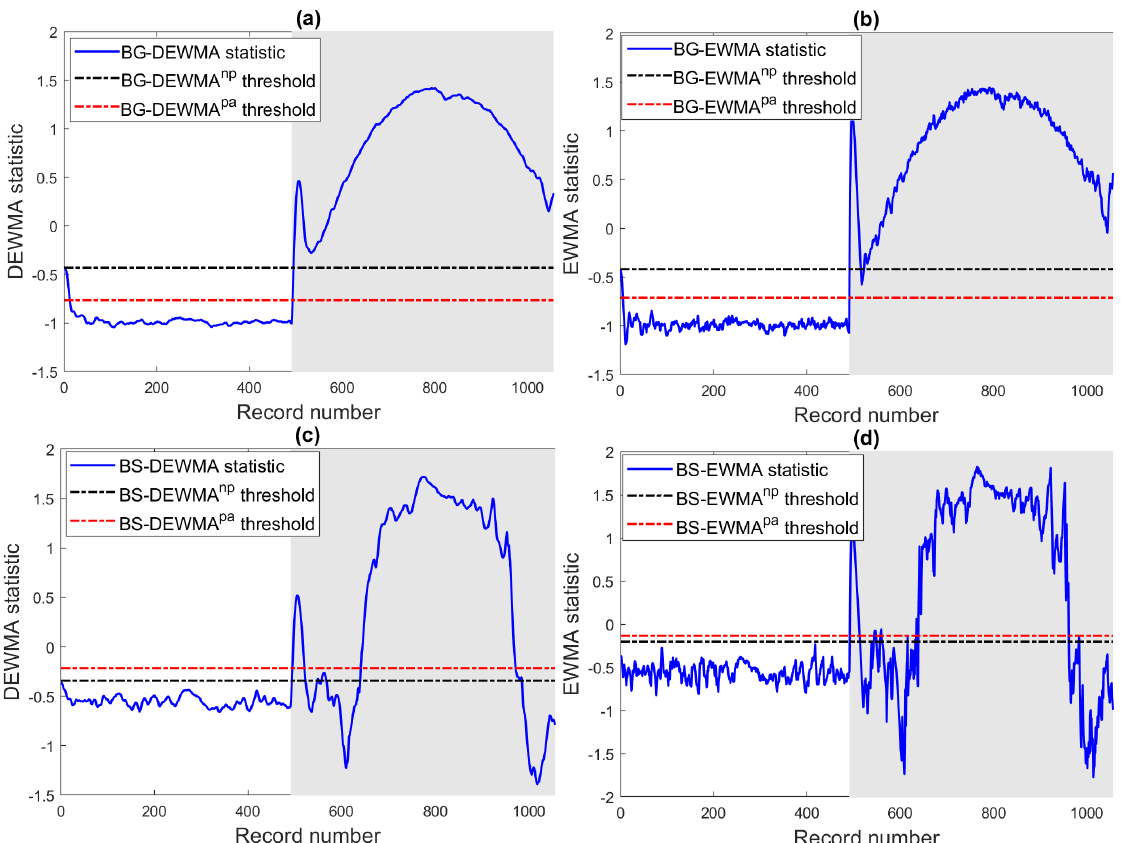
Figure 18. Results of the BG-based schemes in the presence of two short-circuited modules: ( a ) BG- DEWMA, ( b ) BG-EWMA, ( c ) BS-DEWMA, and ( d ) BS-EWMA